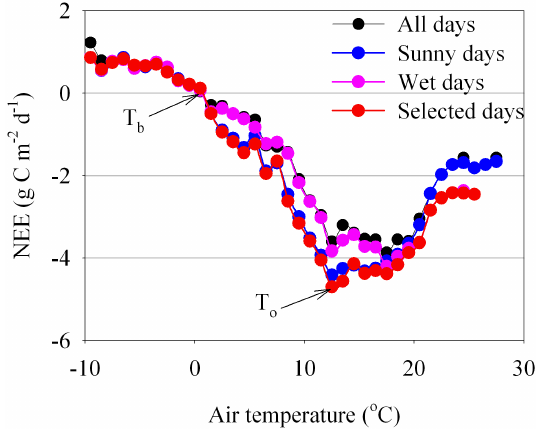
Fig. 2. Typical example of response curve of net ecosystem ex- change (NEE) with temperature at DE-Tha site. Negative values at y-axes indicate that carbon is absorbed by the ecosystem, while positive values indicate that carbon is released by the ecosystem to the atmosphere. The curve of “all days” was derived from all mea- surements without any data filting; the curve of “sunny days” was derived after excluding the cloudy days; the curve of “wet days” was generated based on the measurements excluding the drought days; and the curve of “selected days” was derived from the mea- surements excluding the cloudy and drought days, and which was used to determine the T b (the transition temperature from ecosys- tem carbon source to sink) and T o (the optimal temperature for net carbon